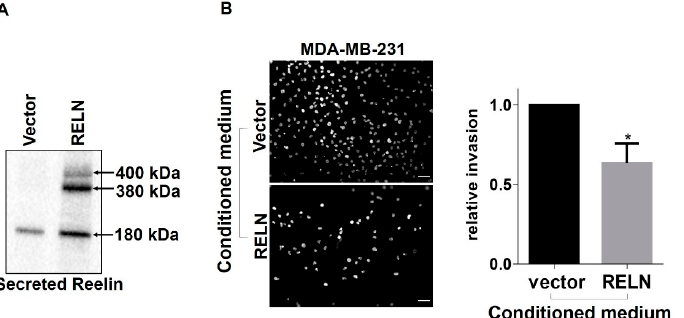
plasmid (see Figure 6). As expected, these cells secreted considerably higher levels of